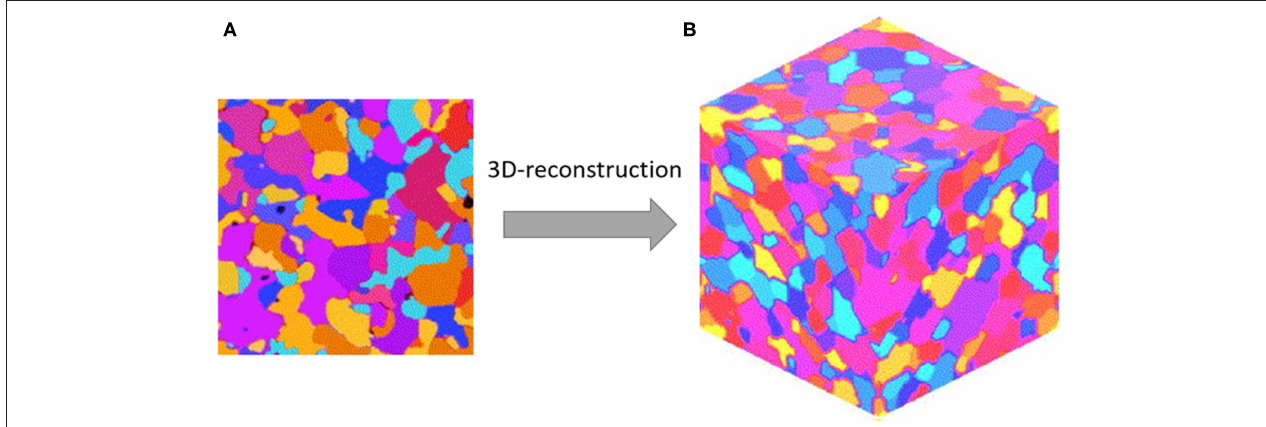
FIGURE 3 | Comparison of experimental and reconstructed micrographs of rolled aluminum alloy AA3002. (A) Shows a two-dimensional polarized light micrograph of the alloy and (B) shows a representative three-dimensional reconstruction of the experimental micrograph in (A) . Reprinted from Sundararaghavan and Zabaras (2005), Copyright (2005), with permission from Elsevier.